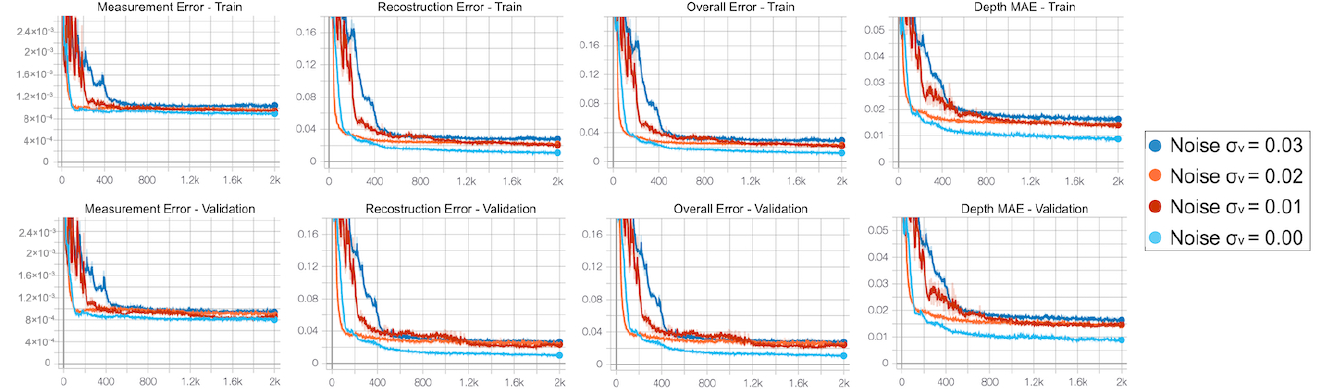
Figure 9. Training curves obtained running the network optimization for noise levels σ v = {0.00;0.01;0.02;0.03} on training and validation sets. The metrics monitored are, from left to right, the measurement error, the reconstruction error, the overall error and the MAE on the depth estimated using the predicted output backscattering vector on synthetic data.